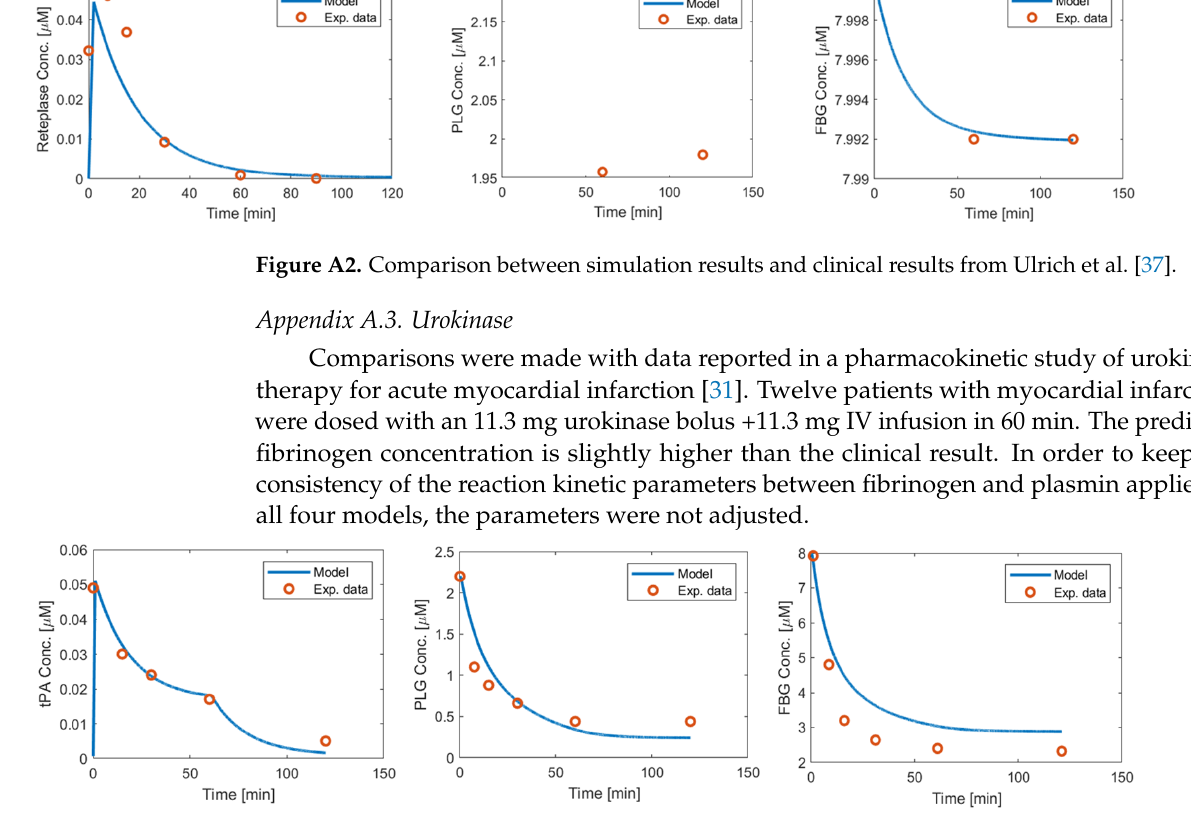
12 of 14 Figure A1. Comparison between simulation results and clinical results from TIBI 10B trial [38]. Appendix A.2. Reteplase Comparisons were made with the data reported in a dosing-range study in 18 healthy volunteers with a single 5.5MU intravenous bolus injection over 2 min [37]. The specific activity of reteplase (BM 06.022) in this case is 0.578 mg/MU. Our simulation results show good agreement with the clinical results in terms of reteplase and FBG plasma concentra-